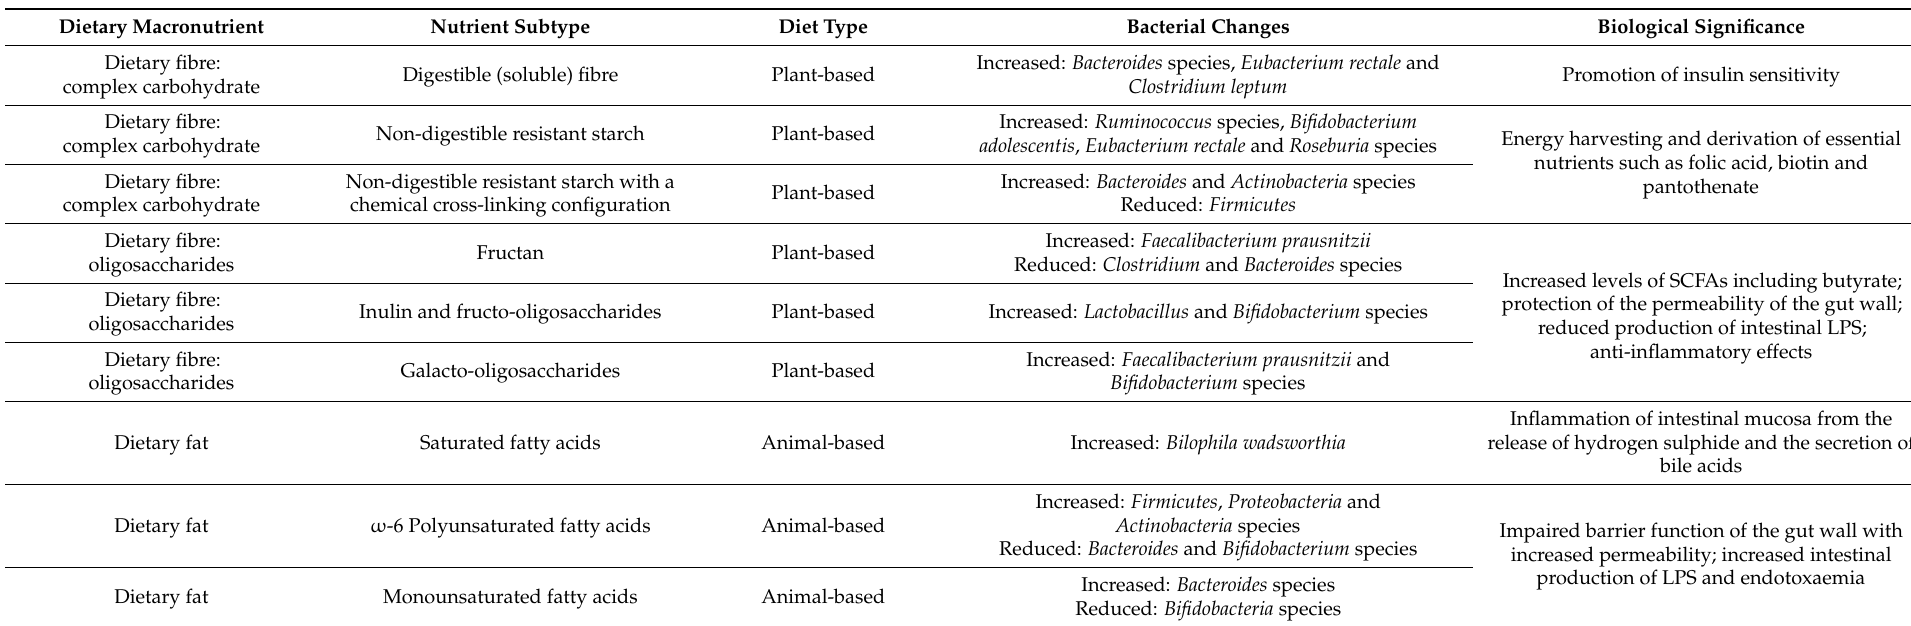
Table 1. Influence of dietary macronutrients (including plant-based dietary fibre and animal-based dietary fat) on the gut microbiota, with changes in bacterial groups and their biological significance. LPS = Lipopolysaccharide; SCFA = Short Chain Fatty